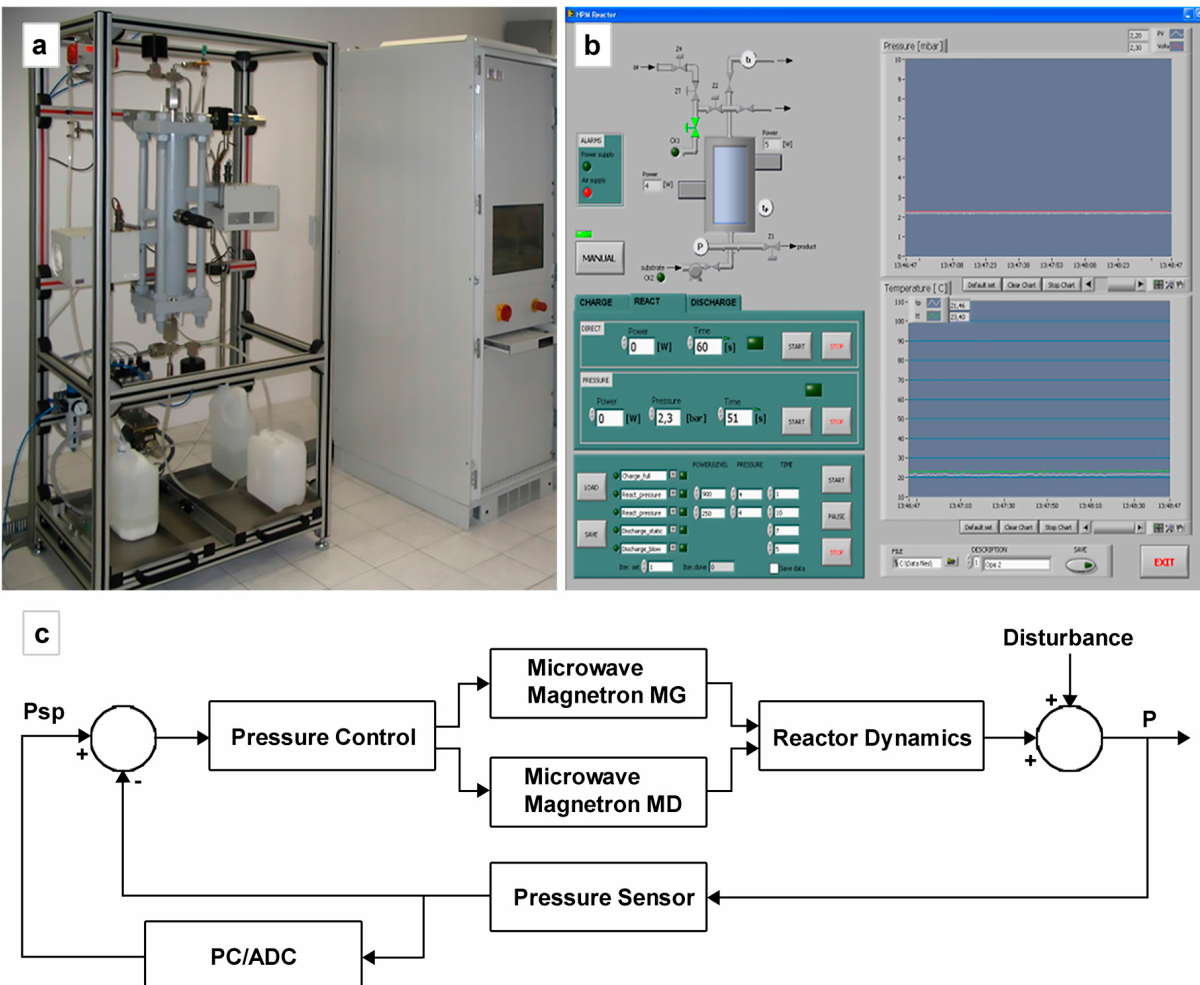
Figure 6. ( a ) The MSS-1 reactor. Stop-flow reactor, automatically operating, with a chamber of volume 250 mL, maximum operating pressure 4 MPa and temperature 240 °C; ( b ) The control panel; ( c ) Schematic presentation of the control system. Psp is the pressure set point. Magnetron MG/MD means the upper and lower magnetron,